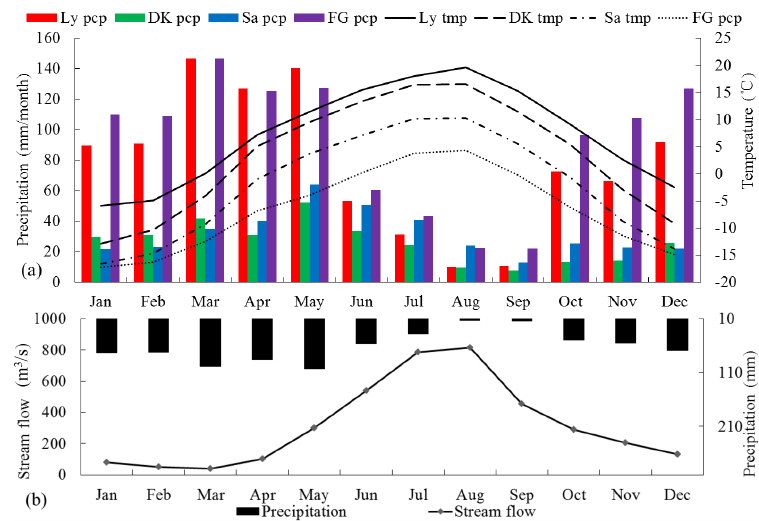
Figure 2. Long-term monthly averages of precipitation and temperature at four stations (a) long-term monthly averages of precipitation and temperature at four stations; (b) long-term monthly averages of stream flow and precipitation (Ly, Dk, Sa, and FG are Lyairun, Daraut-Kurgan, Sarytash and Fedchenko Glacier stations, respectively).